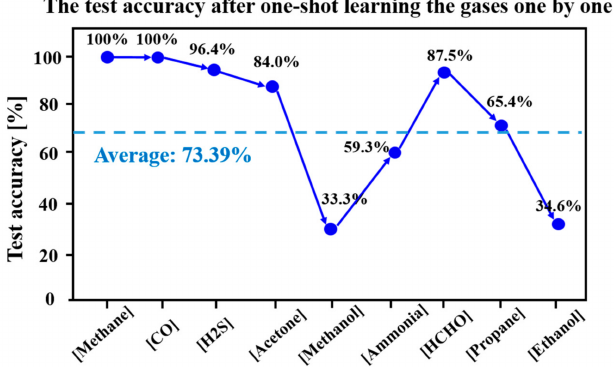
Figure 6. The test accuracy after one-shot learning the gases one by one.